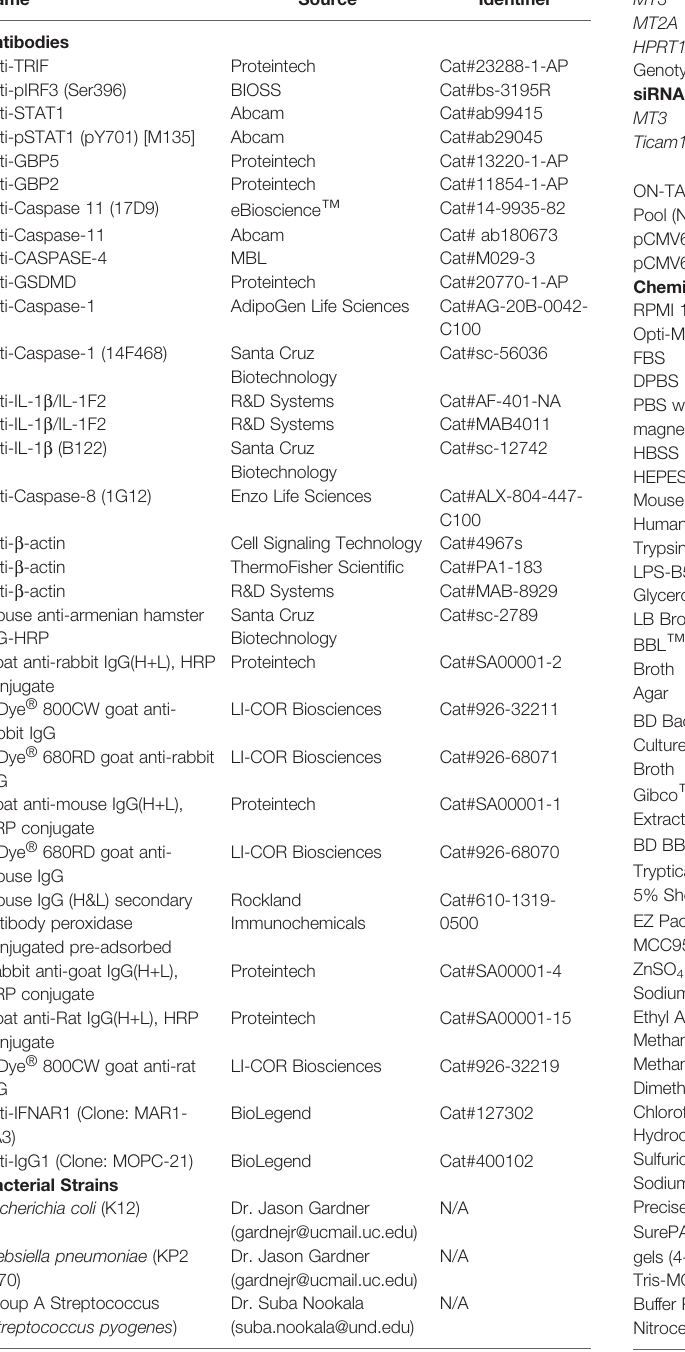
TABLE 2 | Reagents and